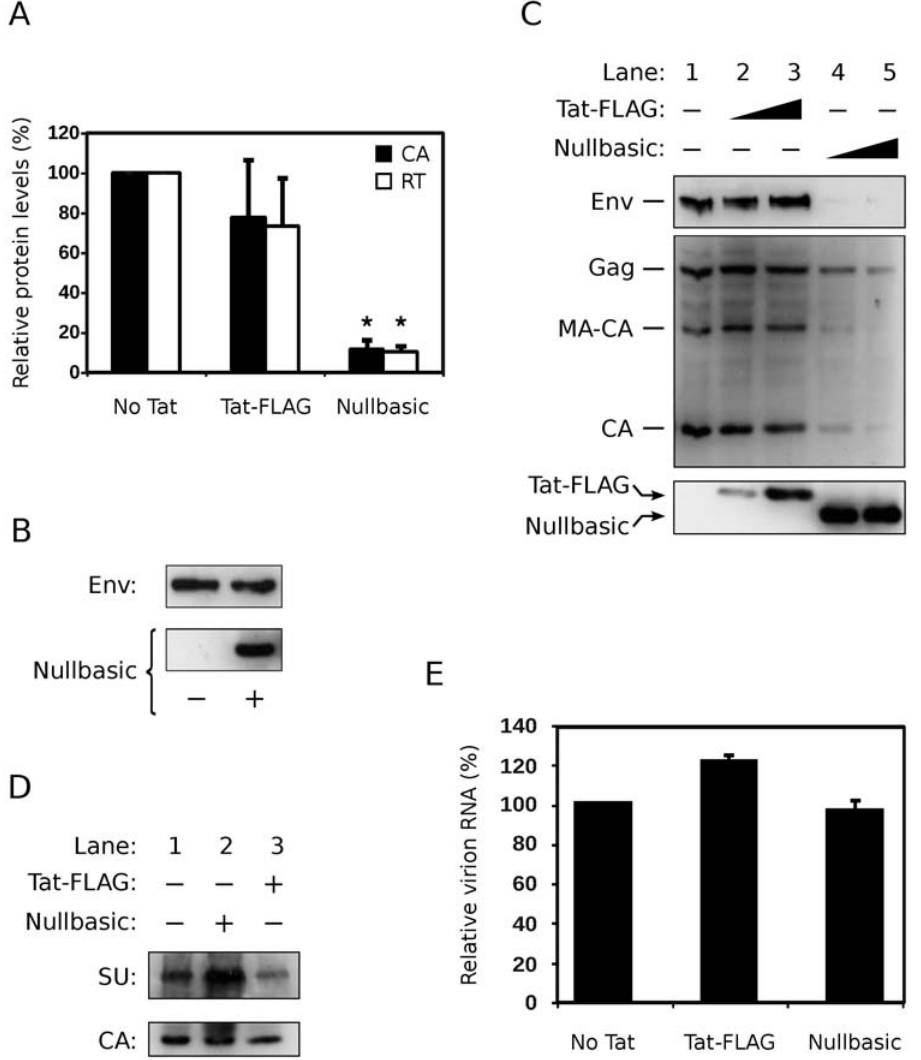
Figure 3. Nullbasic inhibits HIV-1 virion production but not composition. ( A ) Virions produced in HEK293T cells co-transfected with 1:4 molar ratios of HIV-1 plasmid (pGCH) to Tat-FLAG, Nullbasic or empty vector (pcDNA3.1 + ; ‘‘No Tat’’) plasmids were assayed for capsid (CA) and reverse transcriptase (RT) concentrations. The CA (black columns) and RT (white columns) concentrations are shown. Columns represent the means and standard deviations of four independent experiments and are expressed as a percentage of the ‘‘No Tat’’ sample. Asterisks indicate significant differences ( p , 0.025, Welch’s t -test) in CA andRT concentrations between Nullbasic andTat-FLAG samples. ( B ) HEK293T cells transfected with a reporter plasmid that expresses Rev-independent Env from the CMV/LTR hybrid promoter of pGCH were co-expressed with (lane 2) or without (lane 1) Nullbasic. Env and Nullbasic were detected by immunoblotting with anti-gp120 and anti-FLAG antibodies, respectively. ( C ) Cell lysates from HEK293T cells expressing pGCH provirus alone (lane 1) or co-expressing either Tat-FLAG (lanes 2 and3; 1:2 and1:4 molar ratios, respectively) or Nullbasic (lanes 4 and 5; 1:2 and 1:4 molar ratios, respectively) were immunoblotted with a monoclonal antibody against HIV-1 SU (upper panel), anti-serum against HIV (middle panel) and a monoclonal antibody against FLAG (lower panel). A b -galactosidase expression plasmid was included in all transfections and western blotting was performed on lysates normalised for b -galactosidase activity. ( D ) Culture supernatants were collected from HEK293T cells expressing pGCH alone (lane 1) or co-expressing either Nullbasic (lane 2) or Tat-FLAG (lane 3). Virions in the supernatants were concentrated by ultracentrifugation before samples containing 50 ng of total CA were immunoblotted with anti-gp120 and anti-CA antibodies. Data in B, C and D are representative of three independent experiments. ( E ) Packaged genomic RNA was isolated from virions produced by HEK293T cells expressing pGCH co-transfected with empty vector (pcDNA3.1 + ; ‘‘No Tat’’) or co-expressing Tat-FLAG or Nullbasic before being quantitated by RT-PCR. The means and standard deviations of two experiments performed in duplicate on independent virus stocks are shown, with values expressed as a percentage of the ‘‘No Tat’’